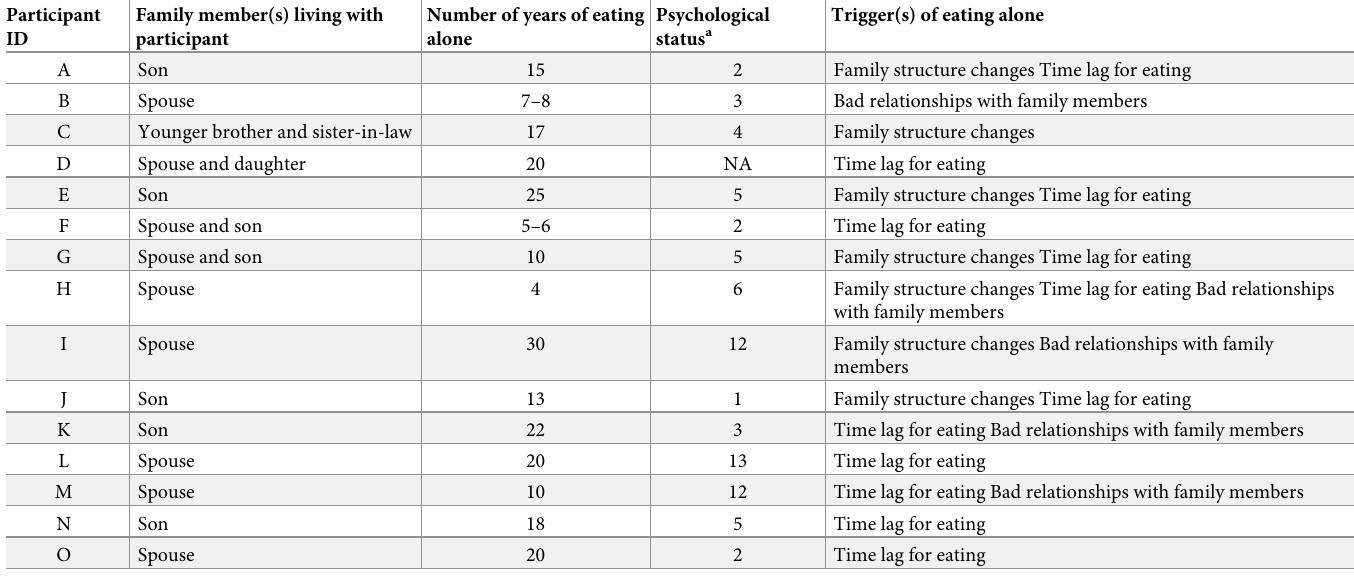
Table 1. Participant